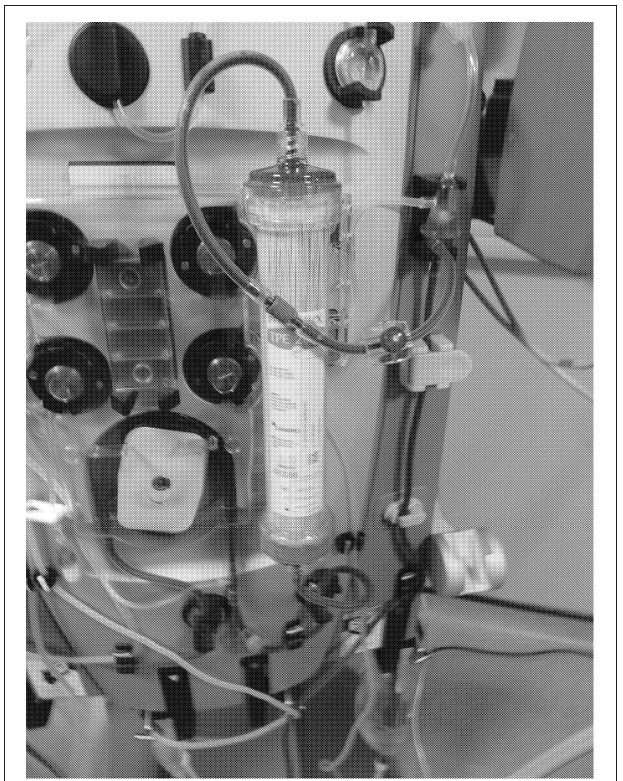
FIGURE 2 | The extracorporeal plasma filtration system can be seen (Prismaflex ® TPE 2000;